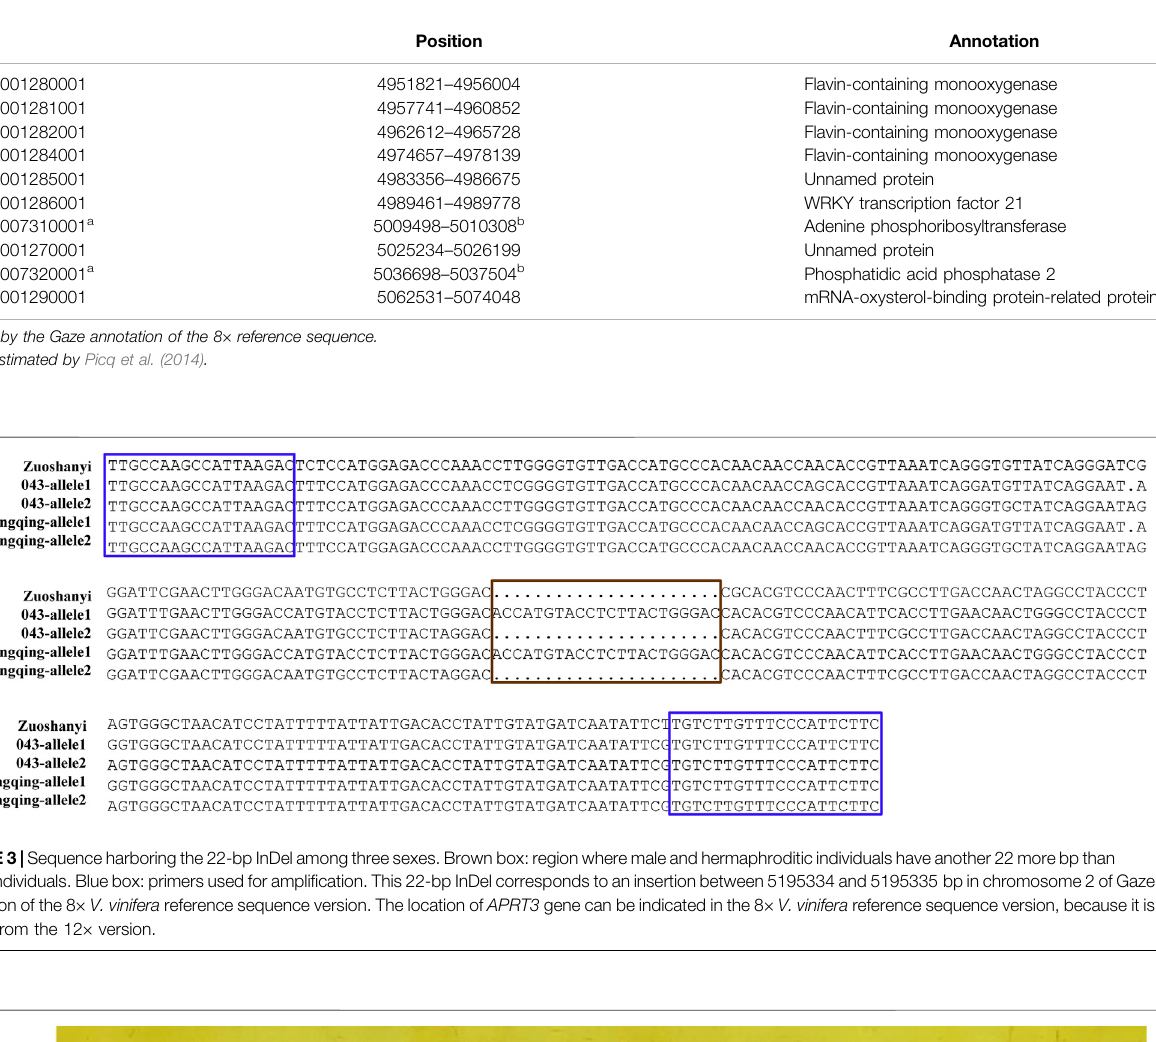
TABLE 2 | Genes located in the predicted region on chromosome 2 of the 12 × reference sequence.